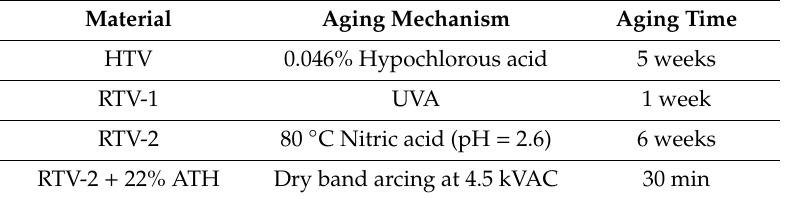
Table 1. List of silicone rubbers (SIRs) and aging mechanisms investigated in this study. Material